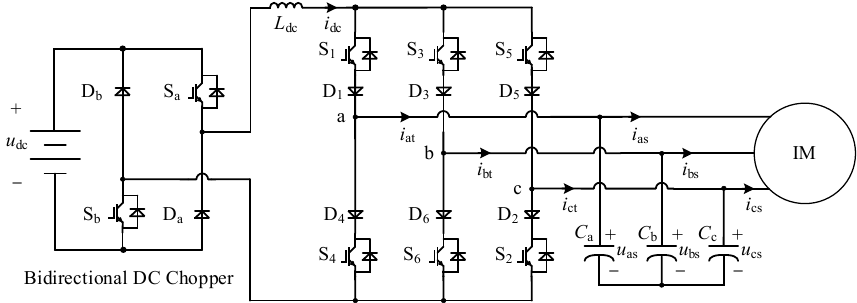
Figure 1. The topology of CSI − fed IM drive system with bidirectional DC chopper.